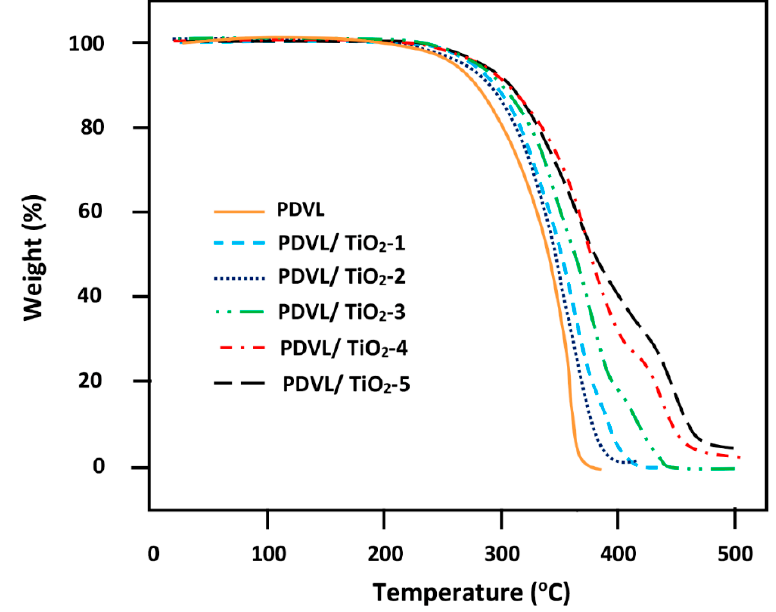
Figure 14. TGA thermograms of pure PDVL and PDVL/TiO 2 nanocomposites with different TiO 2